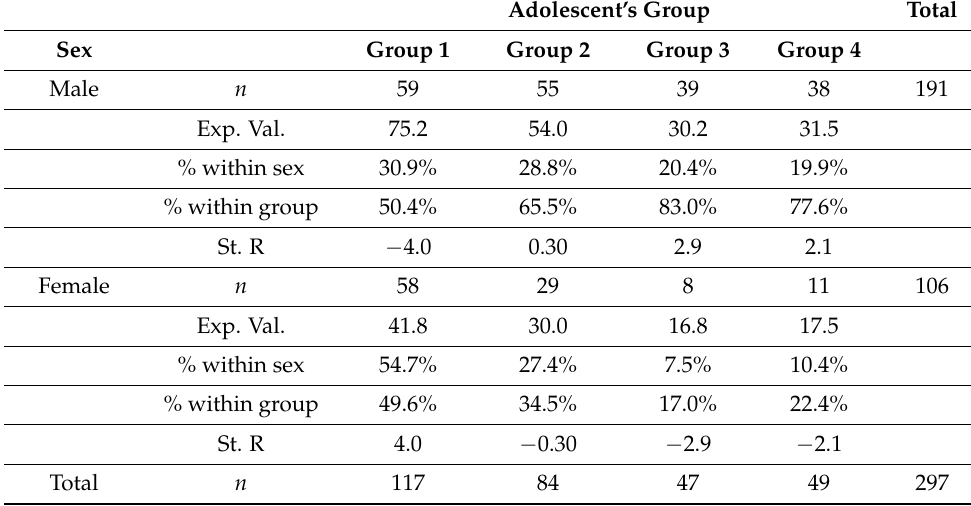
Table 2. Association between adolescents’ sex and motor vehicle collisions